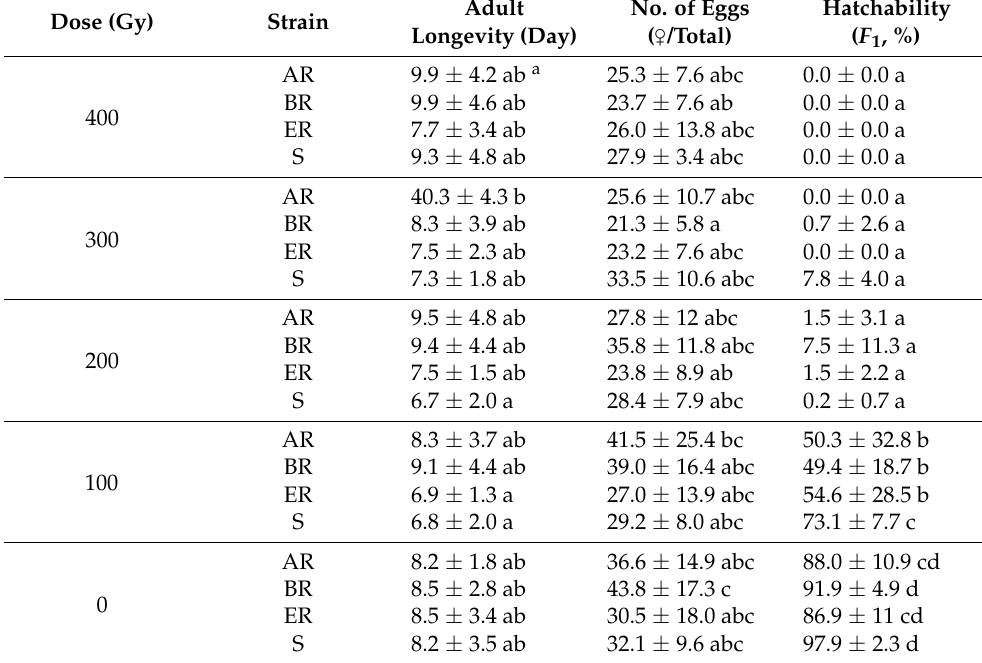
Table 4. Effect of electron beam irradiation on adults of the AR, BR, ER, and S strains of T. urticae . Dose